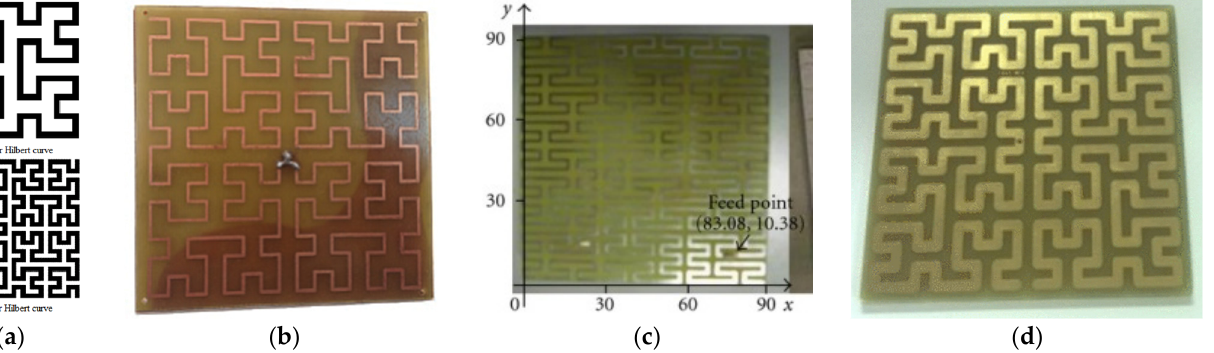
Figure 15. Fractal antennas: ( a ) Third ‐ and forth ‐ order Hilbert iteration layout, ( b ) The front face of the fourth ‐ order Hilbert fractal antenna on an FR4 substrate studied in [106], ( c ) The third ‐ order Peano fractal antenna studied in [107,108], and ( d ) Moore ʹ s fractal antenna studied in [109]. Peano fractal antenna studied in [107,108], and ( d ) Moore’s fractal antenna studied in